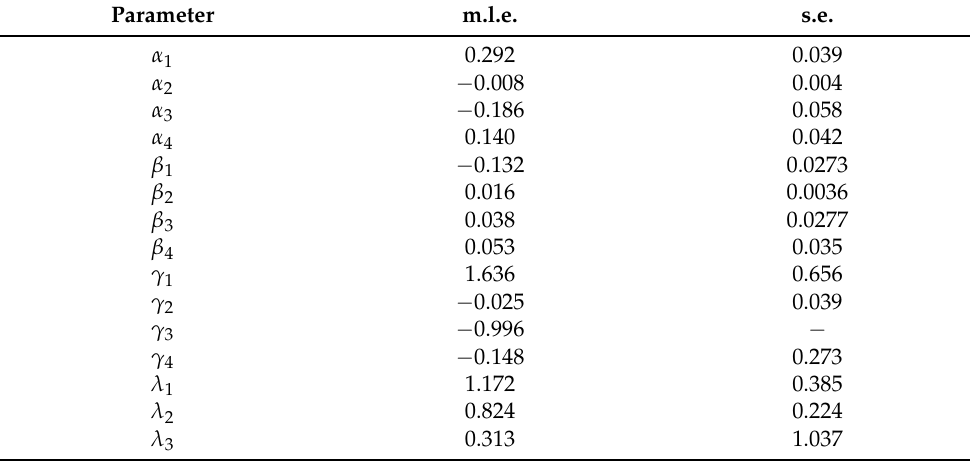
Table 2. Final model estimates and its standard error (s.e.) for the Australian Health Service Utilization